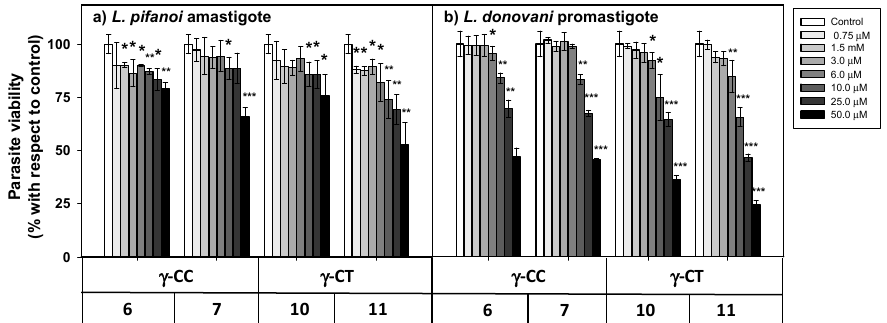
Figure 5. Viability of Leishmania sp. parasites after 4 h incubation with peptides 6, 7, 10 and 11 . ( a ) L. pifanoi axenic amastigotes. ( b ) L. donovani promastigotes. Axenic Leishmania parasites (20 × 10 6 cells/mL) were incubated with the peptides, and MTT reduction measured immediately after 4 h incubation. Viability was represented as the percentage of MTT reduction (mean ± SD). Statistical significance with respect to control parasites: p ≤ 0.05, (*); p ≤ 0.01, (**); p ≤ 0.001, (***). Results are representative of one out of three independent experiments. Samples were made in triplicate.